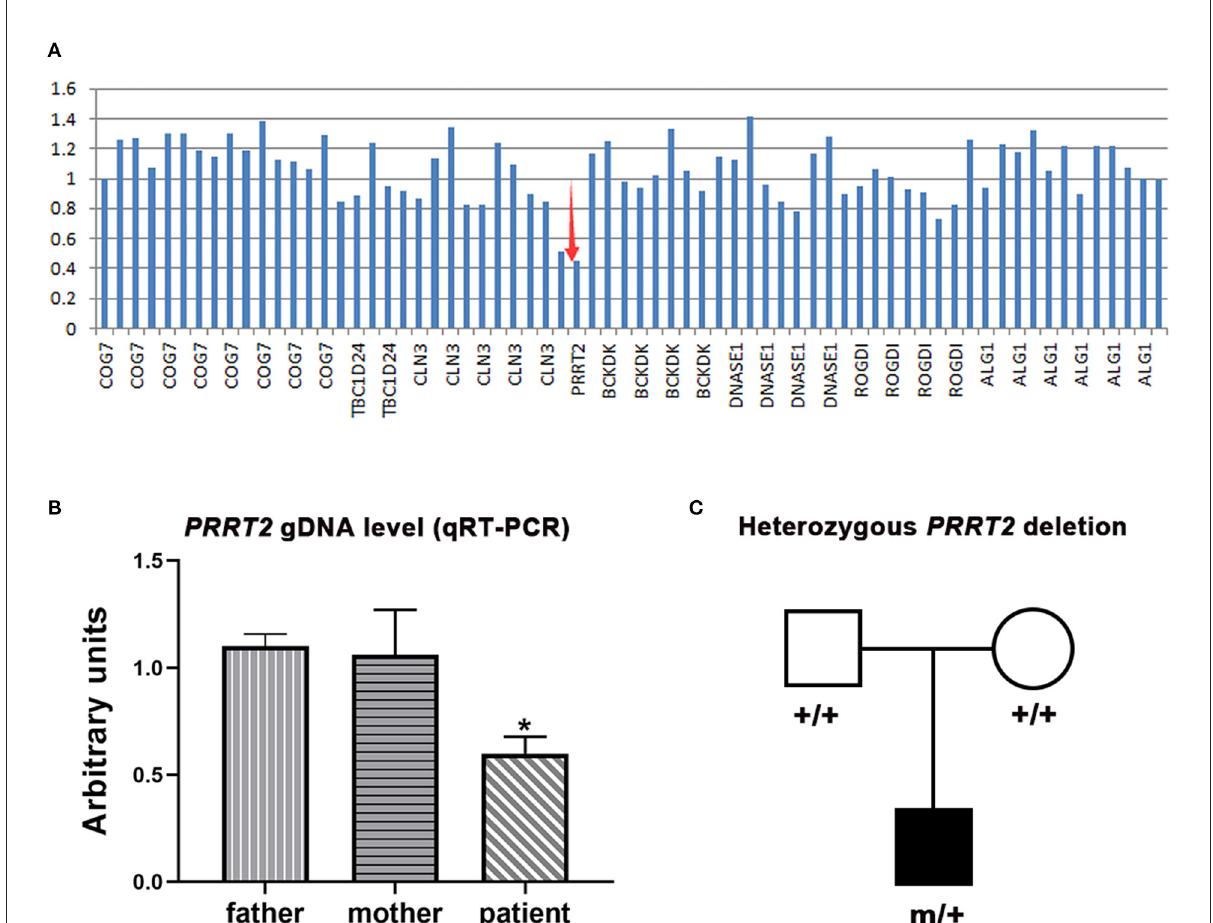
FIGURE2 Genetic data of the cases with PRRT2 variants. (A) Copy number variations analysis showed a heterozygous PRRT2 deletion (red arrows). (B) Relative quantification of genomic DNA (gDNA) confirmed the deletion. The patient presented a reduced PRRT2 gDNA level (half of the level